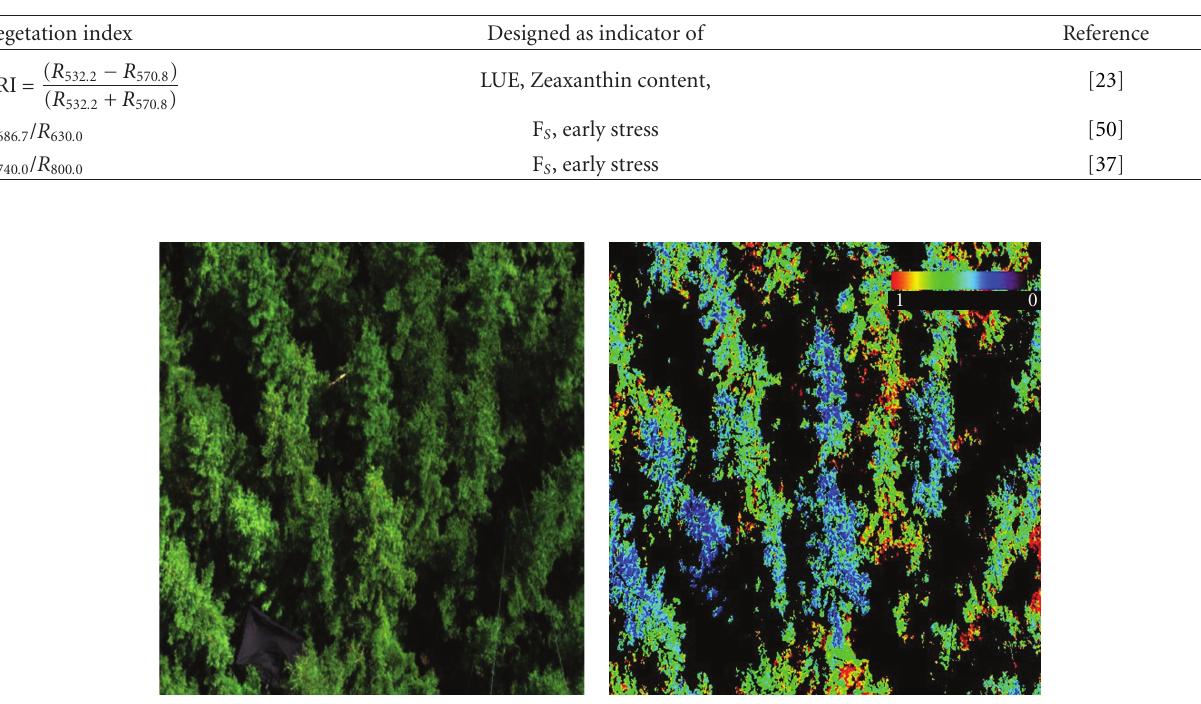
Table 1: Vegetation indices (VIs) used in this study. R λ is reflectance at a wavelength λ in nm, [L.UE: light use e ffi ciency; F S : steady-state